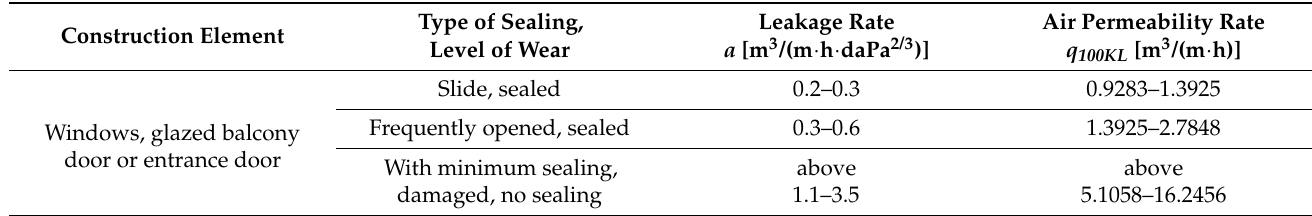
Table 4. Approximate values of the rate of outdoor air leakage through leaks